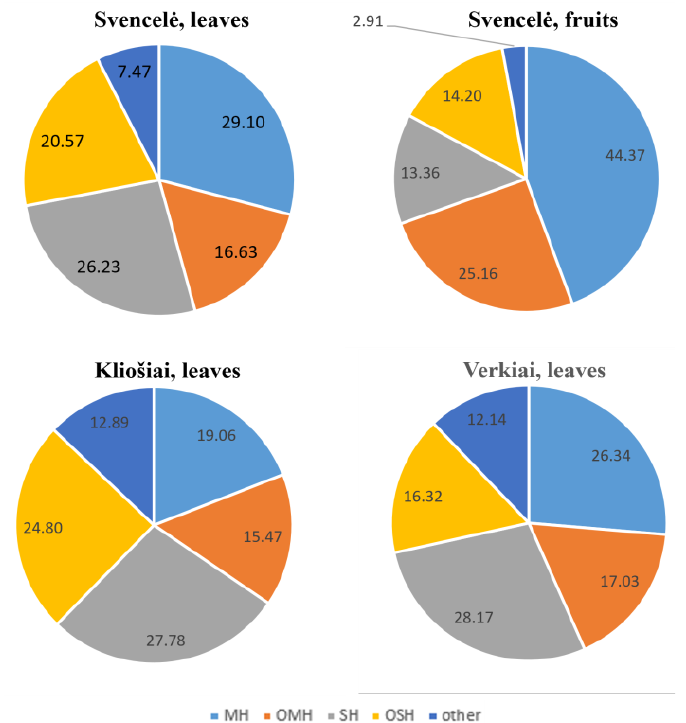
Figure 1. Percentage distribution of the terpene classes in the essential oils of the leaves and fruits of Myrica gale growing in different habitats (MH — monoterpene hydrocarbons, OM — oxygenated monoterpenes, SH — sesquiterpene hydrocarbons, and OS — oxygenated sesquiterpenes).